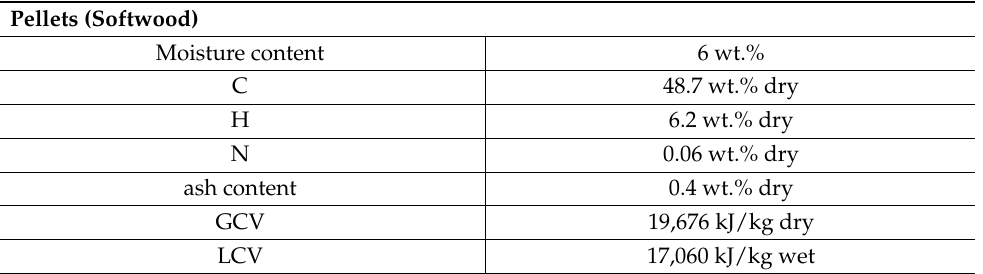
Table 1. Chemical characterisation of wood-pellets [24].